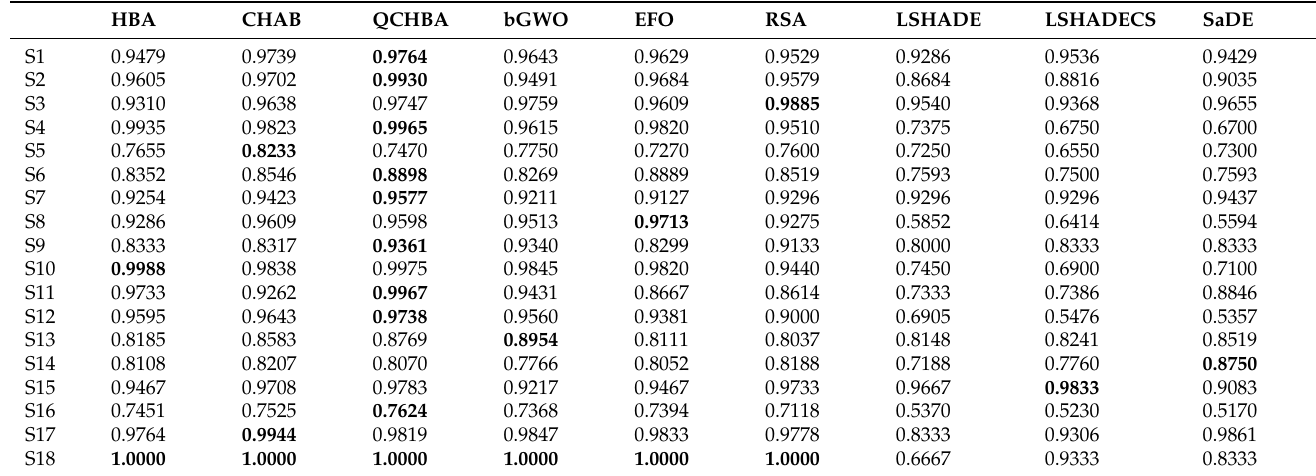
Table 6. Average of accuracy obtained using QCHNA and other methods.